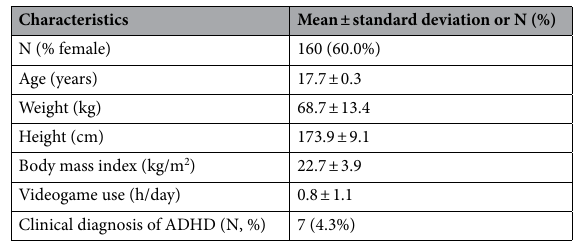
Table 1. Characteristics for participants with valid weekly sleep and valid sleep measured the night prior to cognitive testing. ADHD attention deficit hyperactivity disorder.